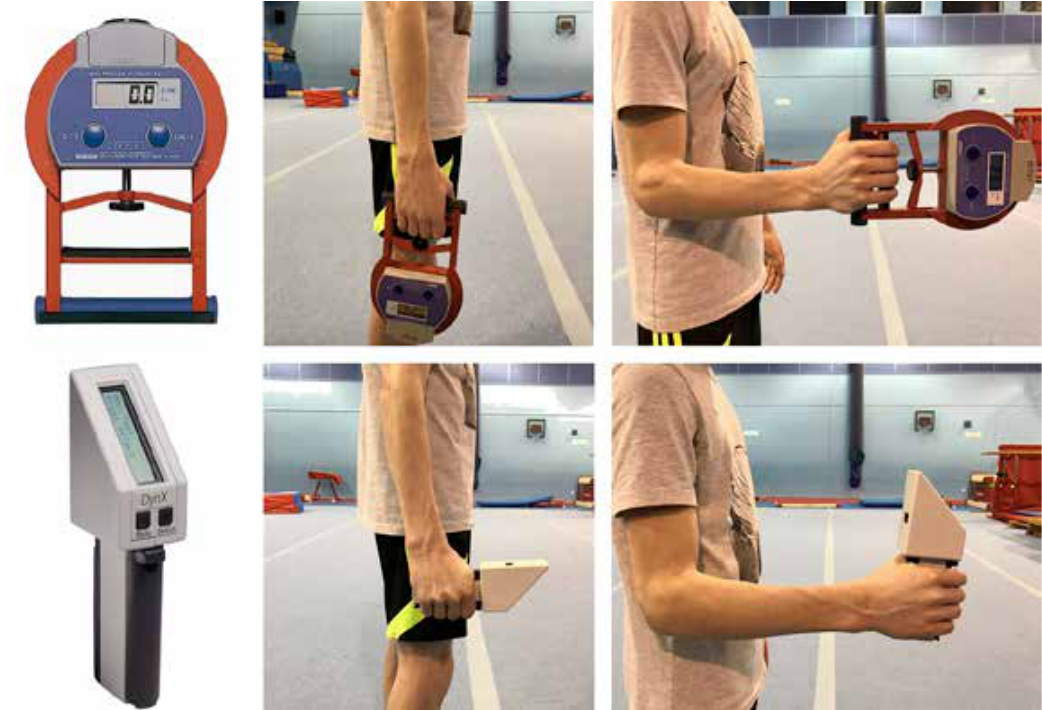
Fig. 1. Handgrip strength test with fully extended and flexed elbow, using TKK (above) and DynX (below)